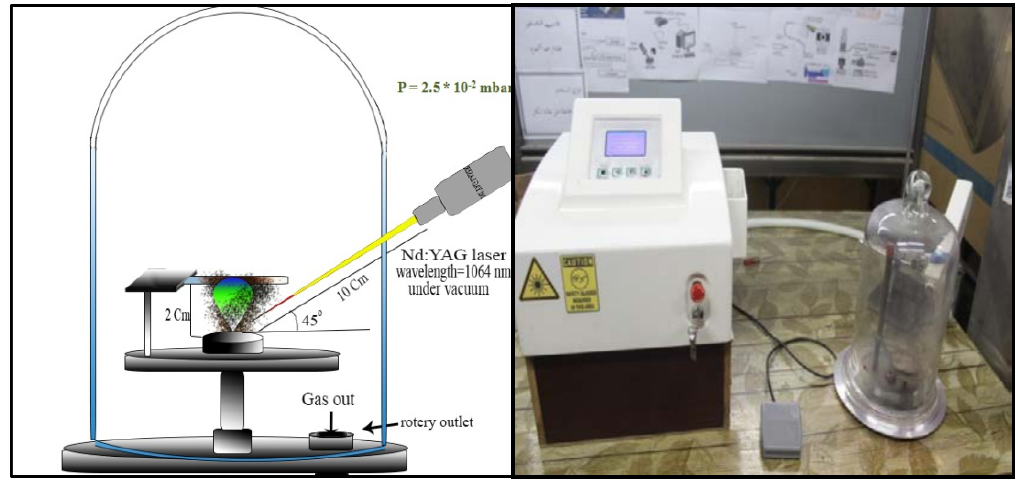
Fig.1: Parts of the PLD